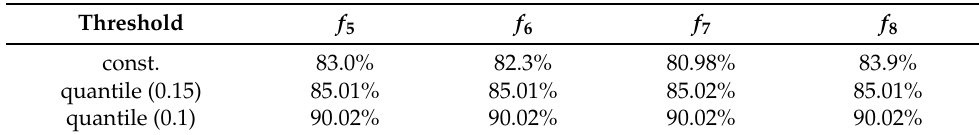
Table 5. Weighted true negative rates (TNRs) for different thresholds.